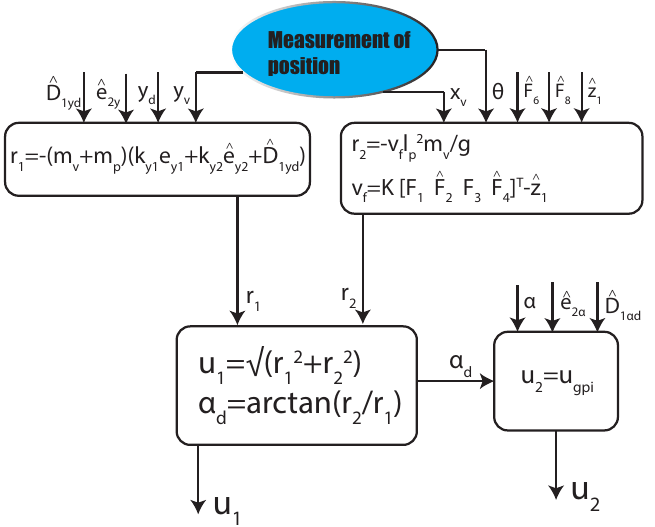
Figure 4. Diagram of the proposed control